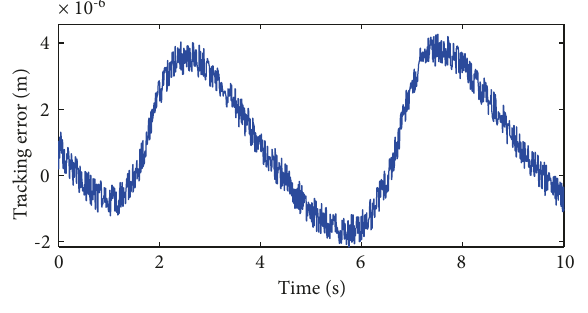
Figure 11: Tracking error curve.